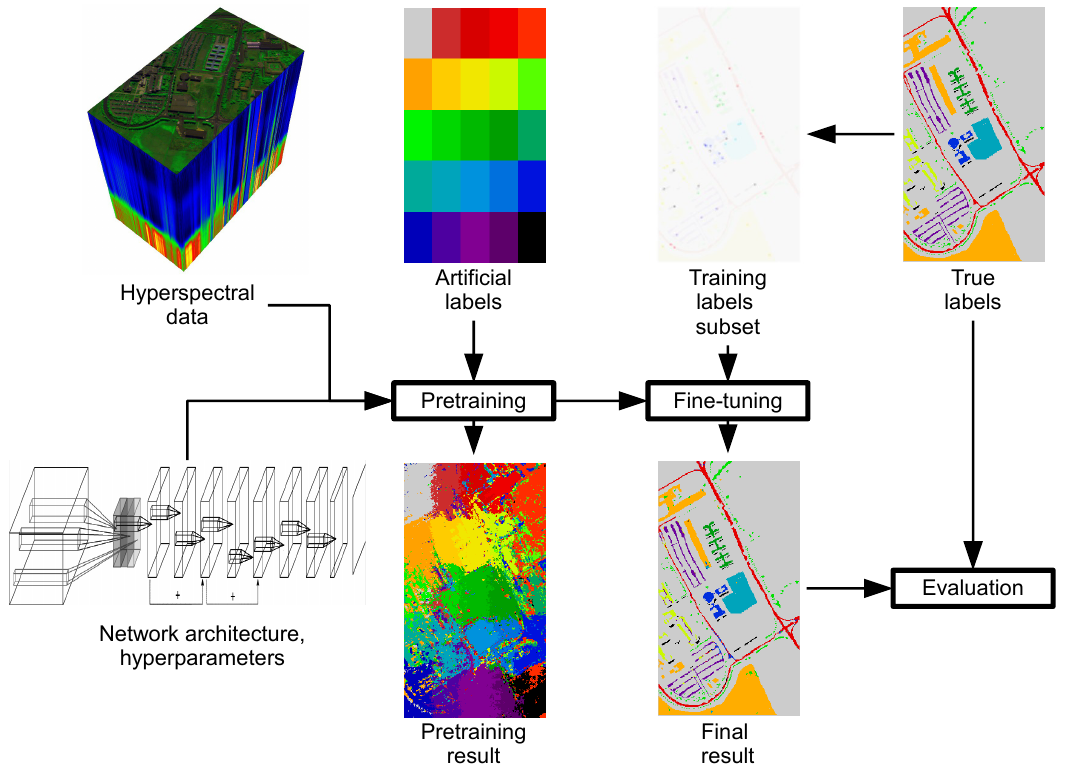
Figure 1. The overview of the unsupervised pretraining algorithm proposed in this work. First, the network is pretrained on grid-based scheme of artificially assigned labels. The network weights are then fine-tuned on a limited set of training samples selected from true labels, consistent with typical hyperspectral classification